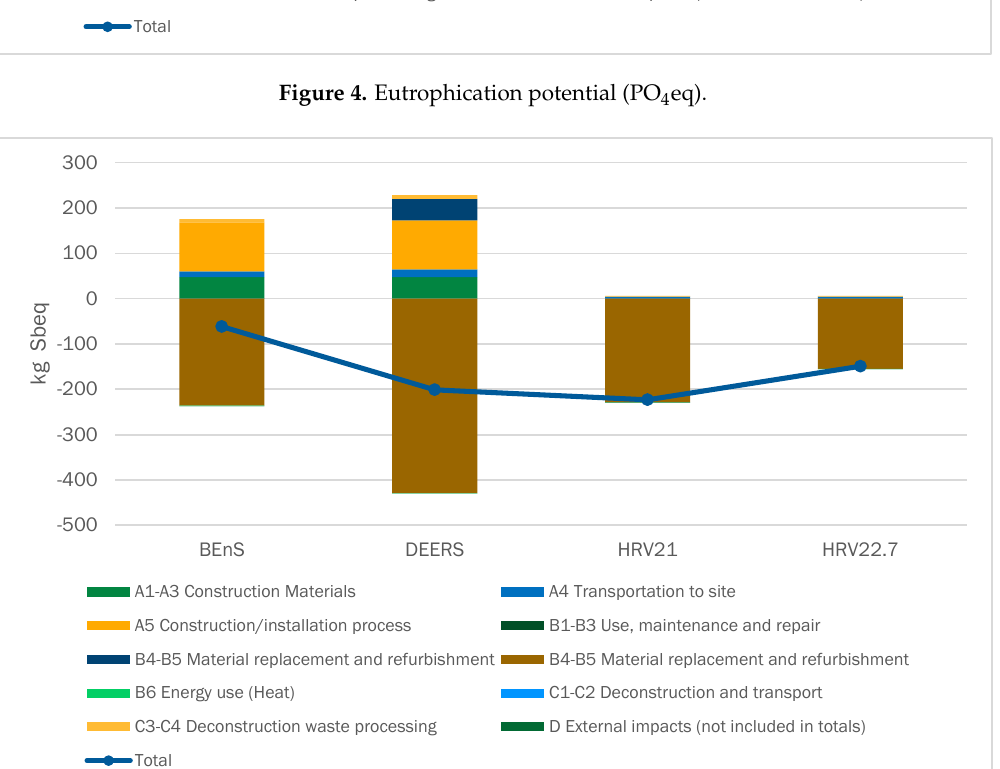
Figure 4. Eutrophication potential (PO 4 eq).